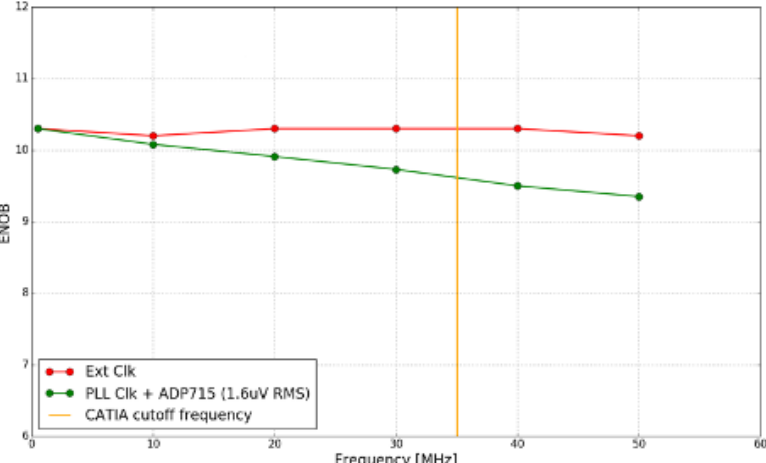
Figure 10. ADC ENOB as a function of the input frequency. The red data points show the ENOB using an external clock, while the green data points show the ENOB using a PLL clock and ADP715 (1.6 V RMS). The yellow line shows the CATIA cut off